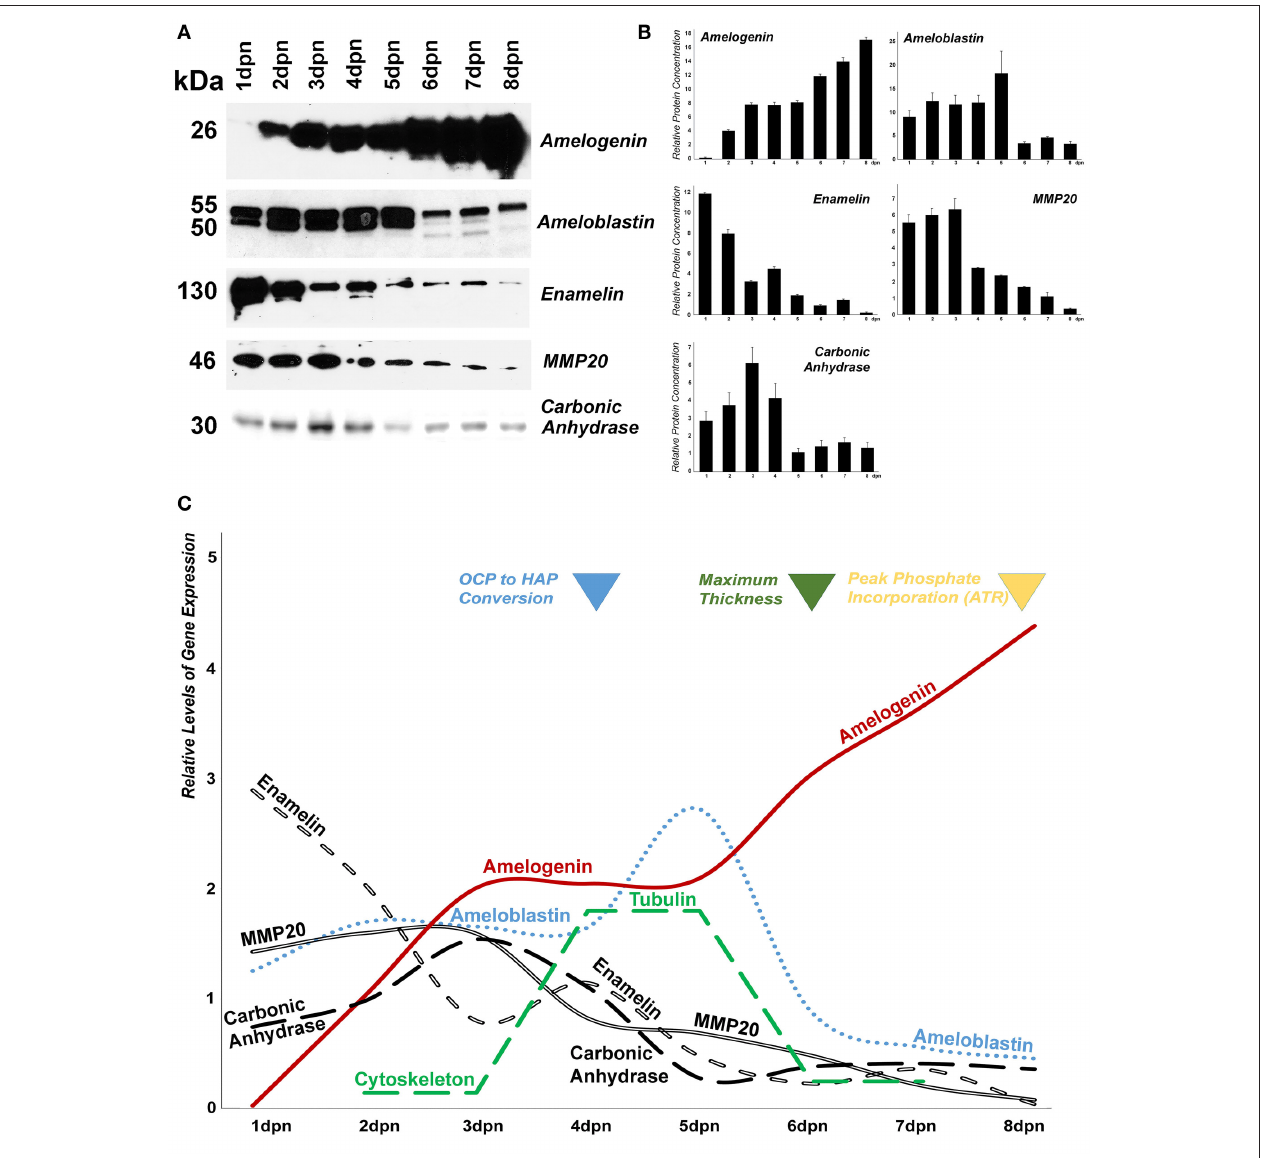
FIGURE 5 | Changes in mouse molar enamel matrix protein levels from postnatal day 1–8. (A) Changes in amelogenin, ameloblastin, enamelin, MMP20, and carbonic anhydrase II, protein levels in enamel matrix preparations as revealed by Western blot. (B) Densitometric evaluation of protein levels in the Western blot shown in (A) . (C) Sketch correlating changes in protein levels with changes in the enamel mineral